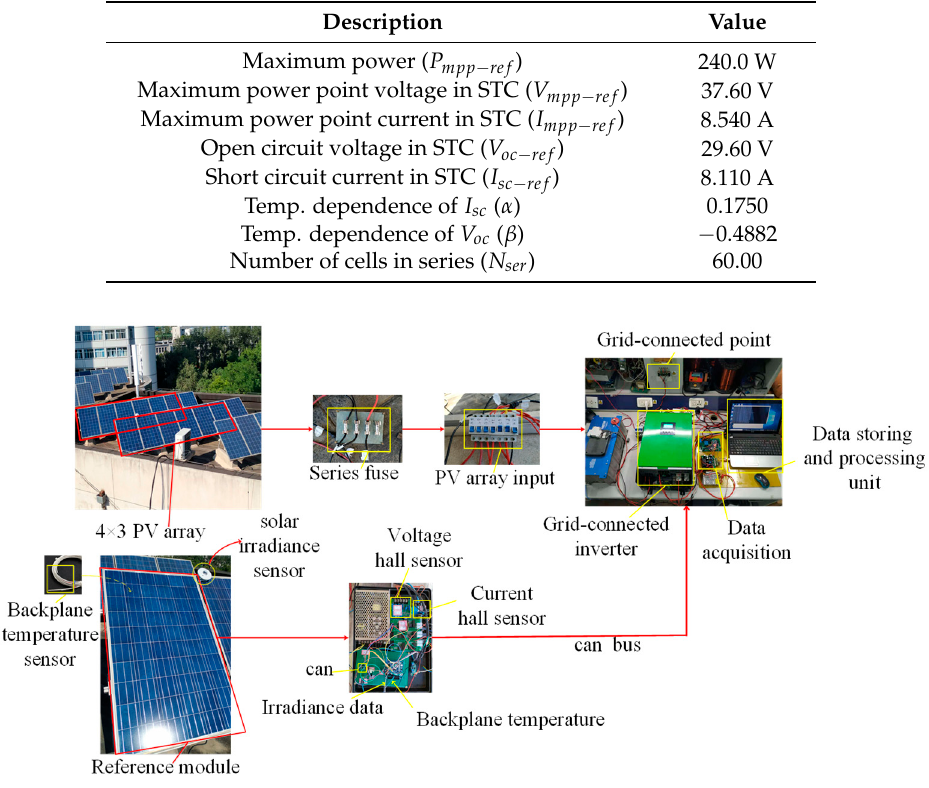
Figure 7. The platform of 4 × 3 PV